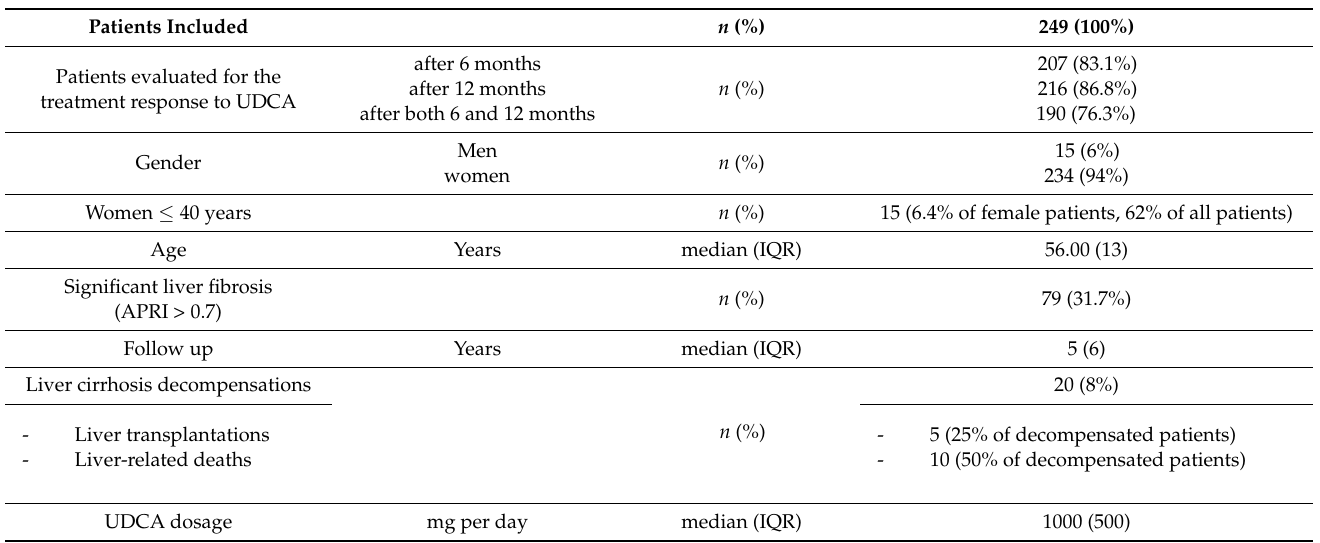
Table 1. Patients’ Table 1. Patients’ characteristics.